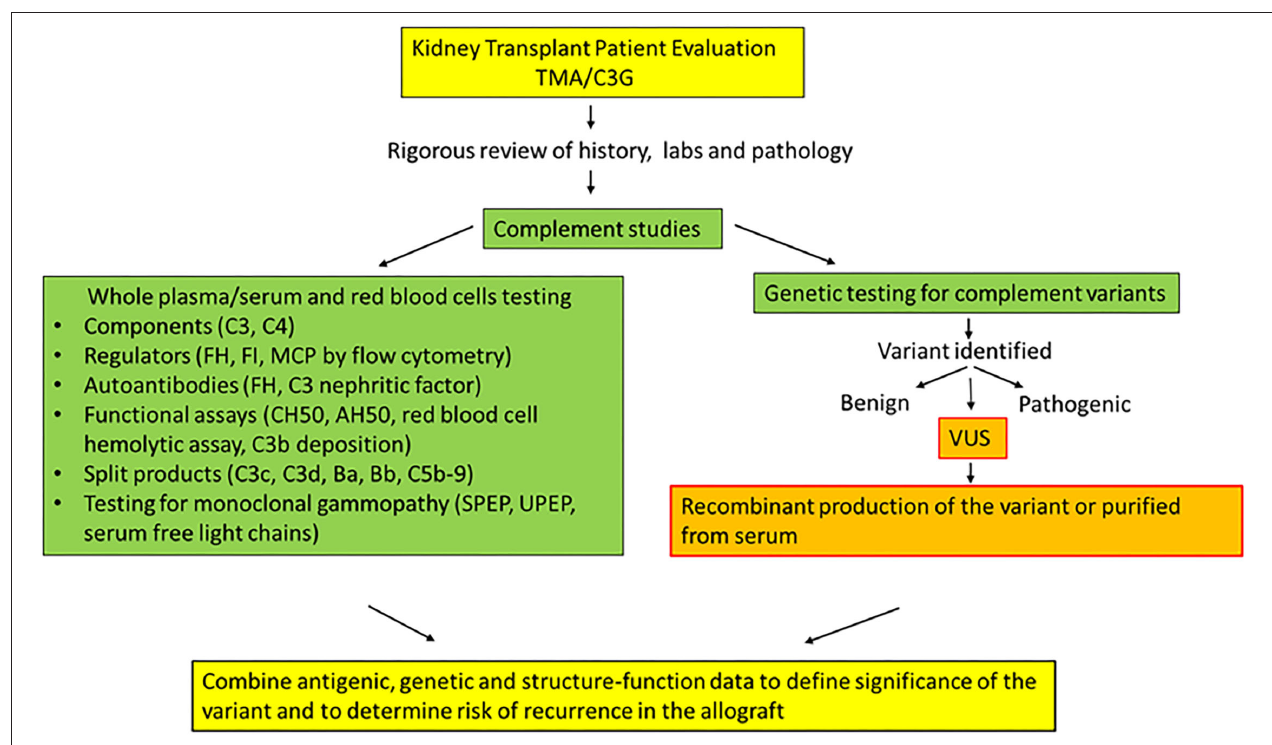
FIGURE 7 | Algorithm with recommended testing and steps to define clinical significance of genetic variants in patients with TMA or